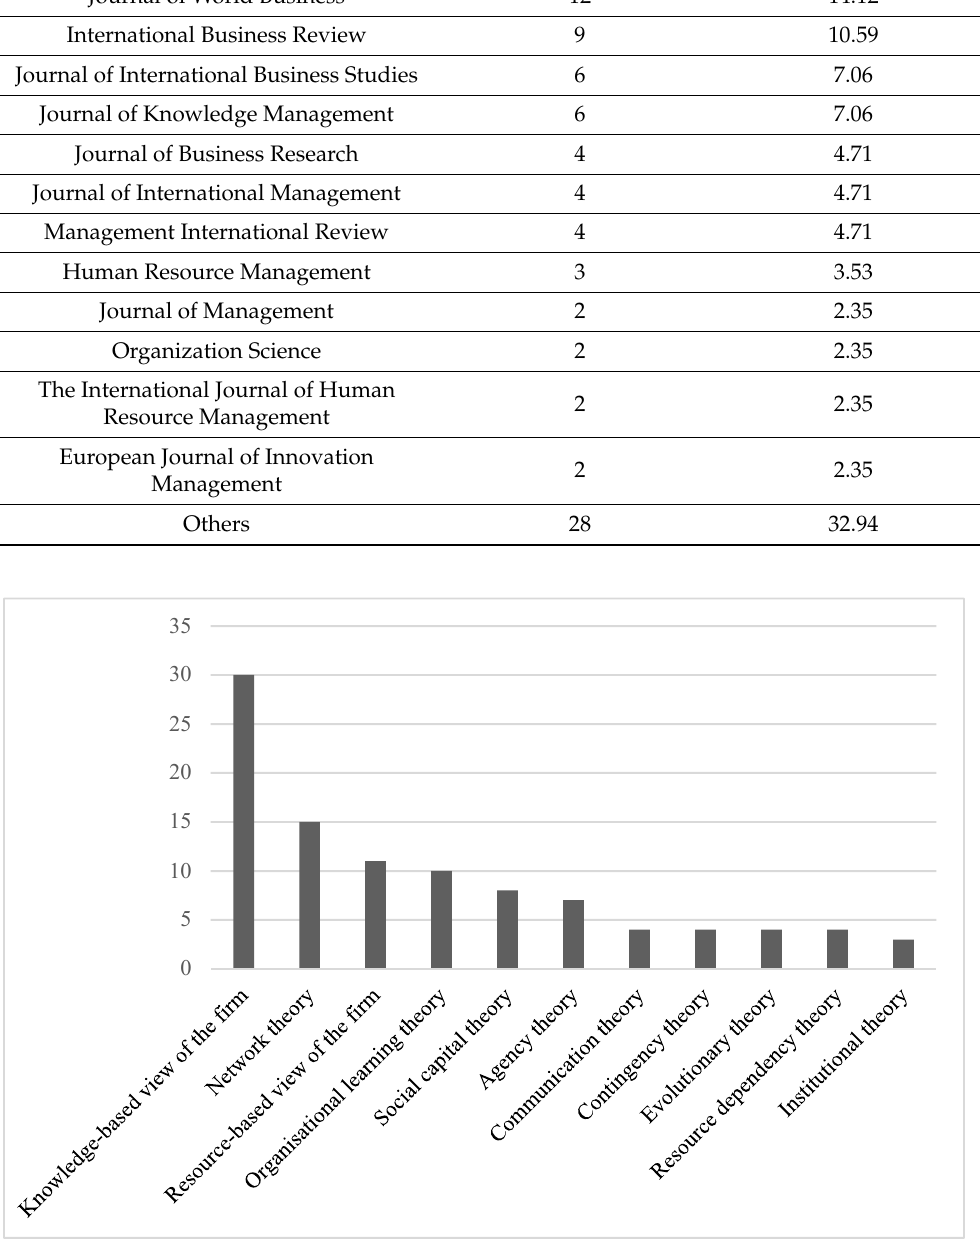
Figure 3. Theoretical foundations of articles under